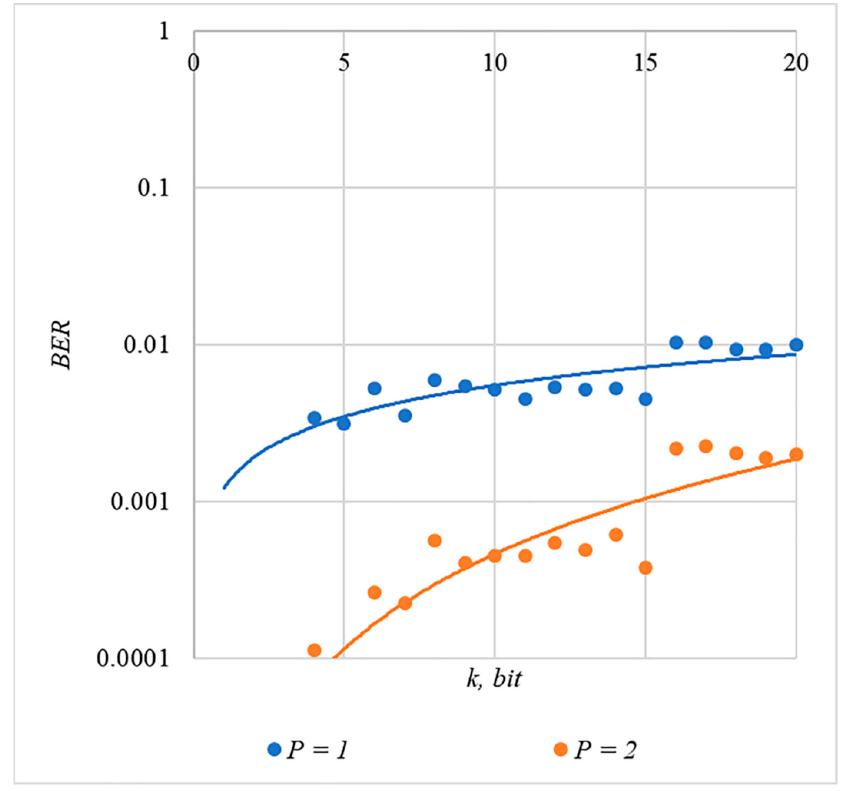
P rule for generating chip codes № 5. Figure 6. BER ( k ) dependencies for different values of